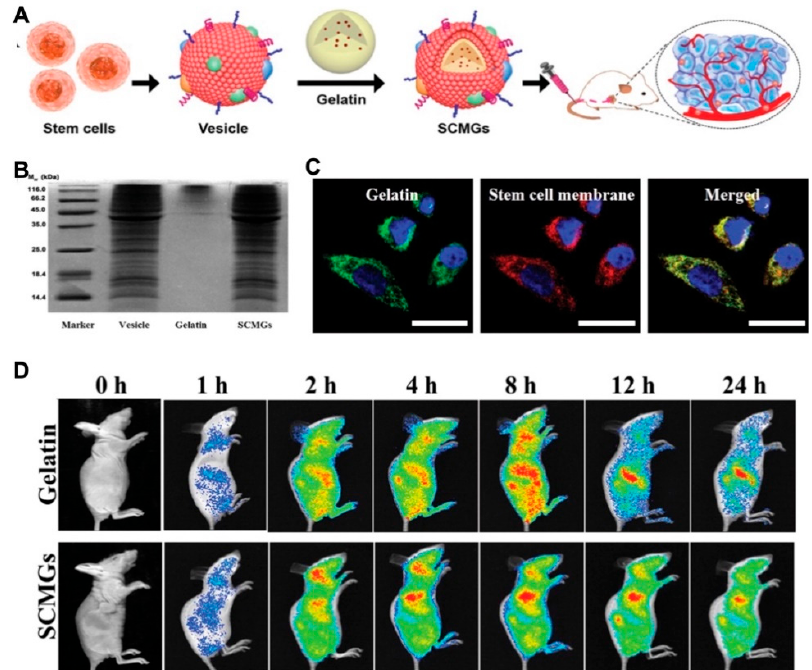
Figure 7. ( A ) The scheme illustrated the preparation of mesenchymal stem cell membrane-coated gelatin nanogels (SCMGs) and the tumor targeting property; ( B ) the surface protein analysis of SCMGs to certify the cell membrane coating; ( C ) confocal fluorescence images for the cell uptake of SCMGs which illustrated the colocalization of green labeled gelatin nanogels and red labeled stem cell membranes; ( D ) in vivo fluorescence imaging of mice after intravenous injection of SCMGs, that illustrated the enhanced tumor targeting and prolonged circulation after stem cell membrane coating. Reprinted with permission from (Small. 2016, 12(30), 4056–4062). Copyright (2016) Wiley Online Library.